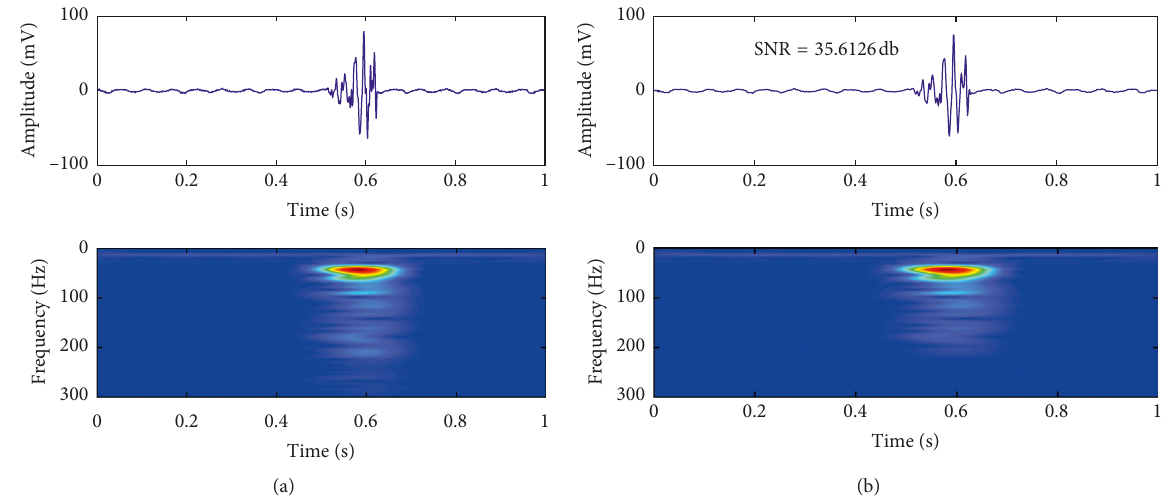
Figure 8: Waveform and spectrum figures: signal and its frequency spectrum before (a) and after (b) Figure 13, i.e., all envelope curves are covered within the